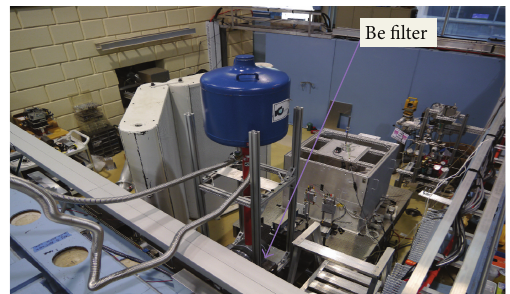
Figure 8: A picture of the new beam line. It consists of a Be filter to remove 𝜆/2 and 𝜆/3 components, spin polarizer, spin analy- zer, adiabatic spin flippers, temperature controlled enclosure for interferometer, and 3